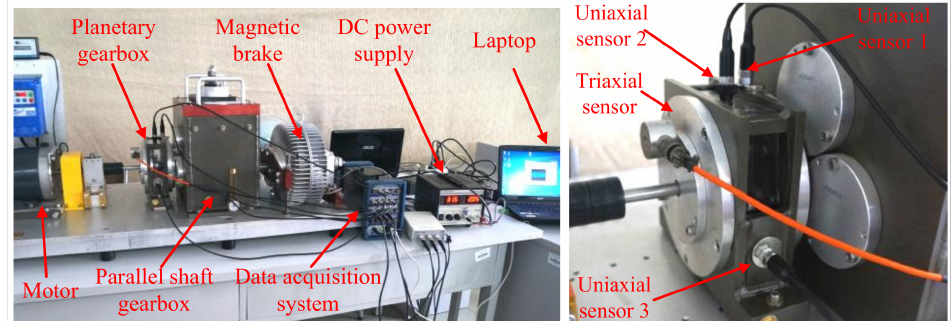
Figure 11. The simulation bench and the installation position of